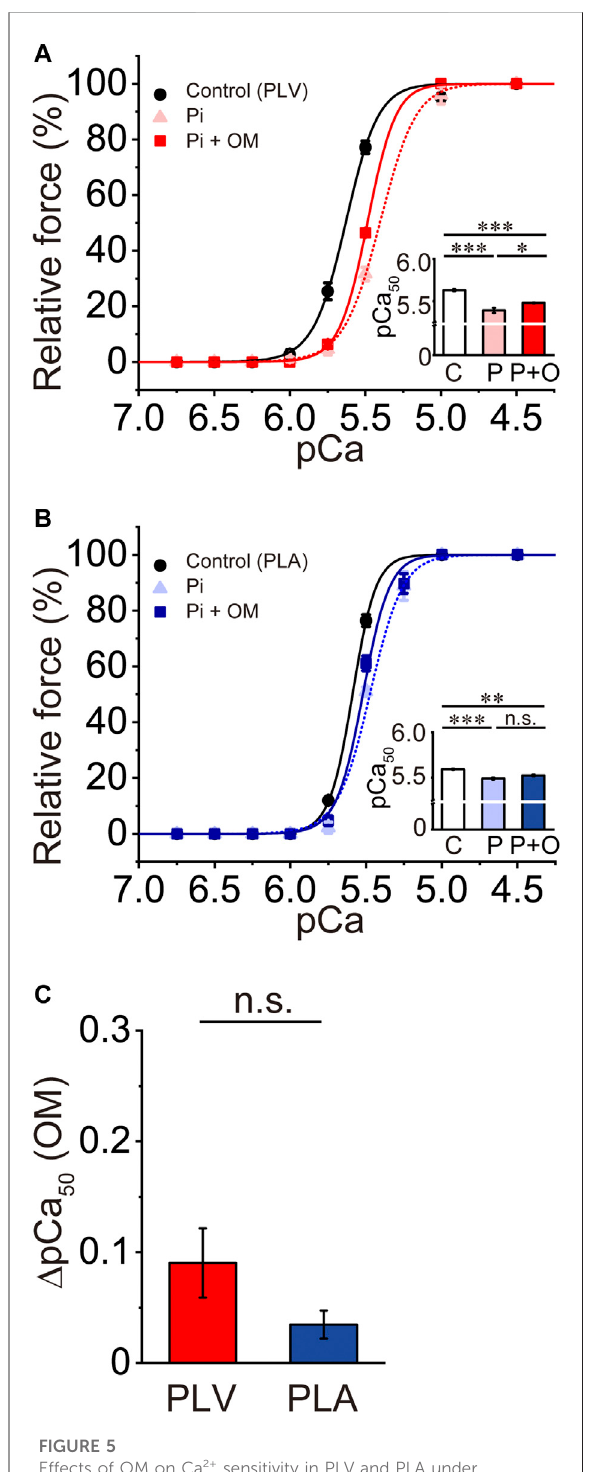
FIGURE 5 Effects of OM on Ca 2+ sensitivity in PLV and PLA under depressed activation condition. (A) Force-pCa curves showing the effect of 1.0 μ M OM on Ca 2+ sensitivity in PLV following 20 mM Pi application. Black circles and solid lines, control (before Pi application); light red triangles and dotted lines, after Pi application; red squares and solid lines, 1.0 μ M OM after Pi application. Inset, pCa 50 values indicating Ca 2+ sensitivity under